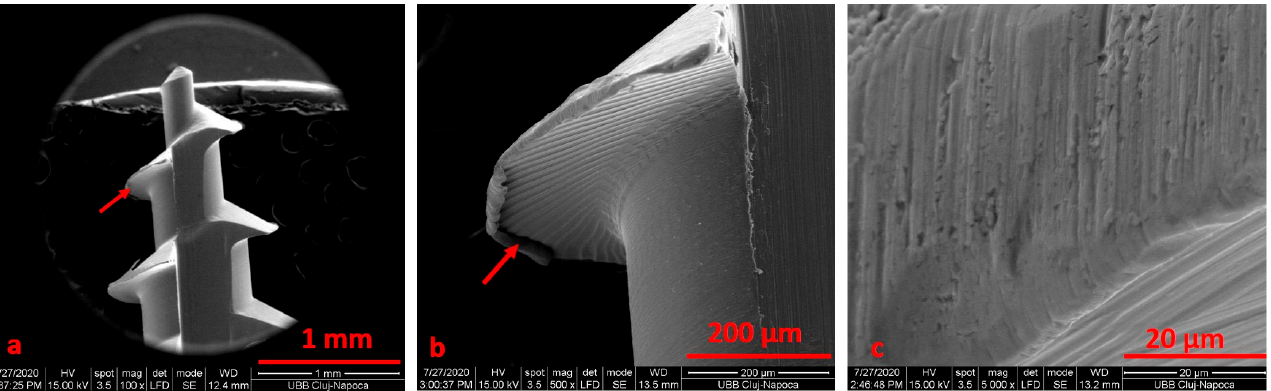
Figure 6. SEM image for the TADs (patient 2) before electrochemical treatment using 1:1 citric acid: phosphoric acid solution at ×100 ( a ), ×200 ( b ), ×2000 ( c ) magnification.